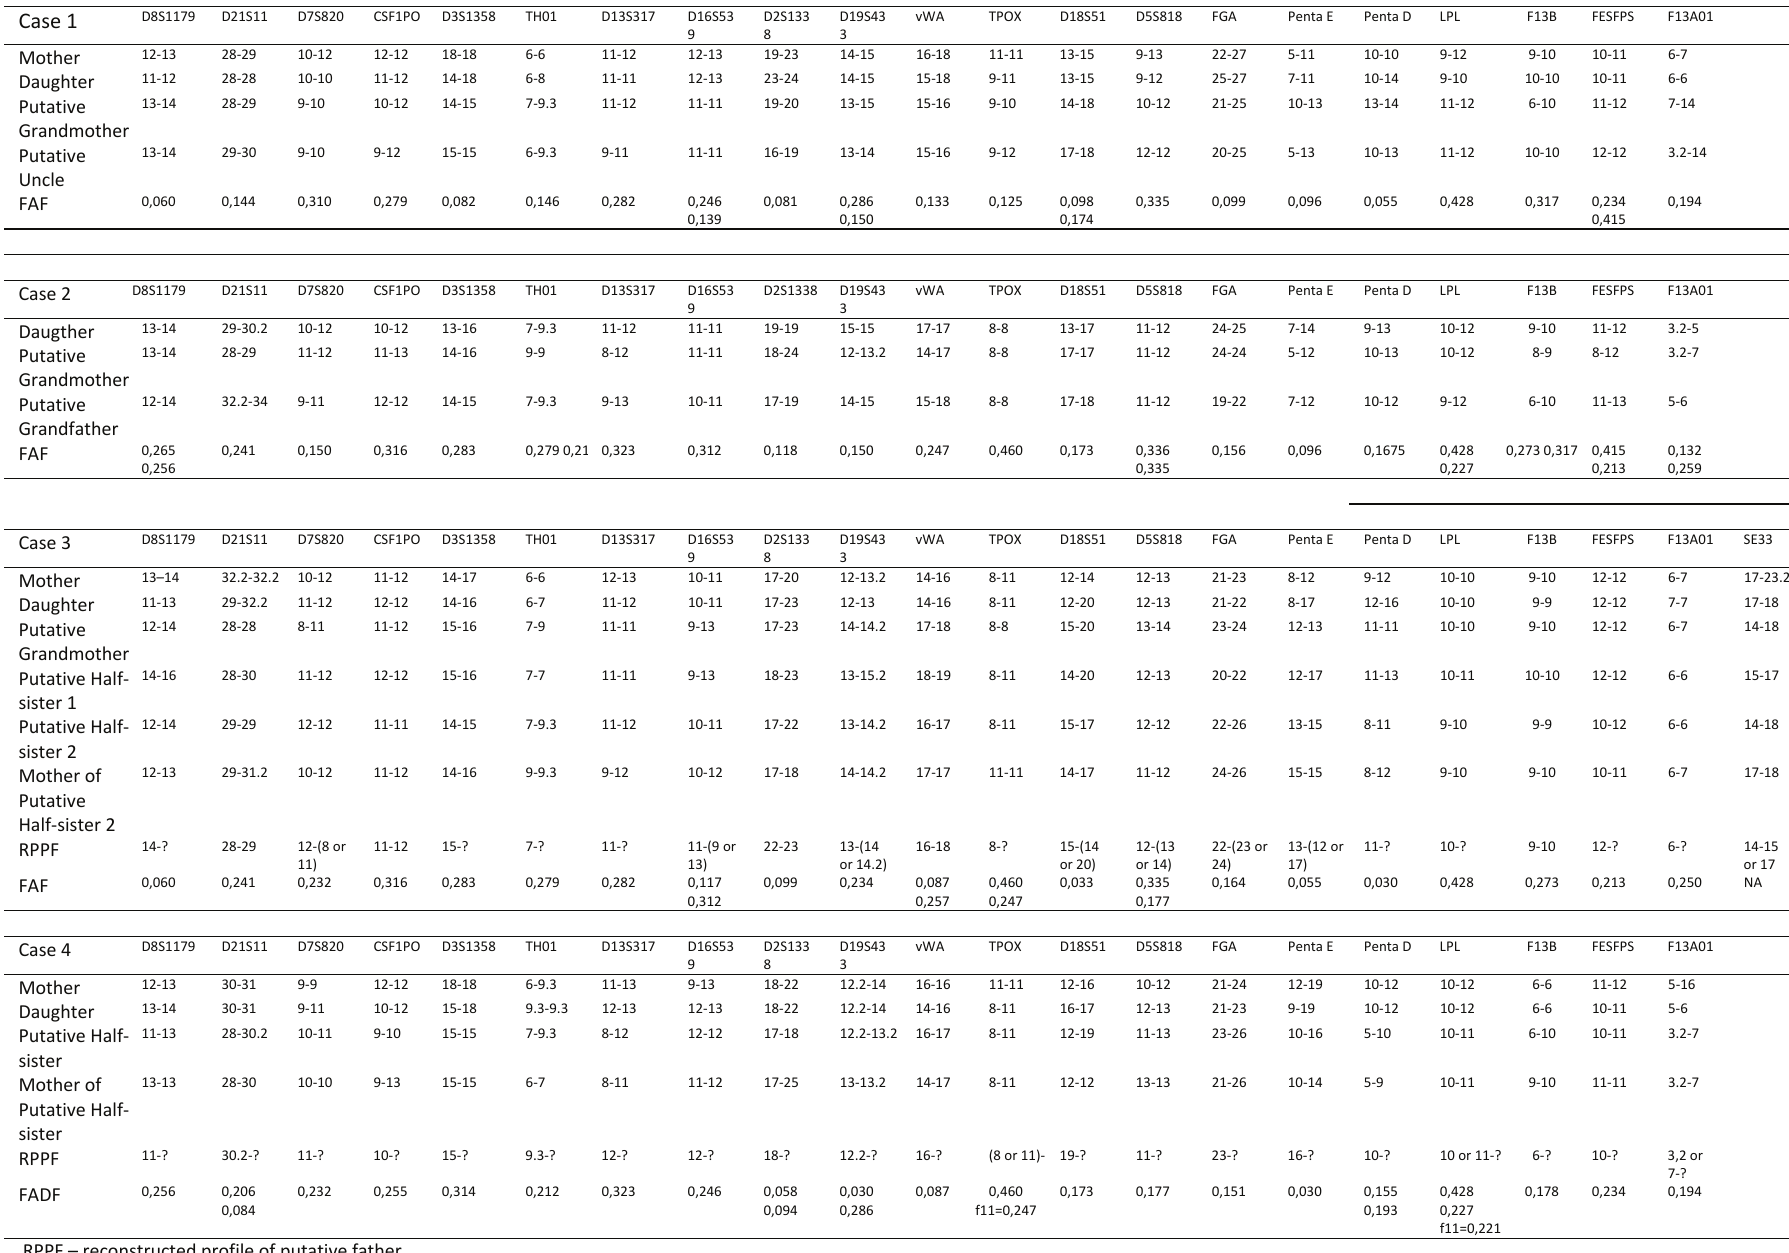
Table S1: Genotypes and frequencies of the allele for AS-STRs transmitted by the deceased